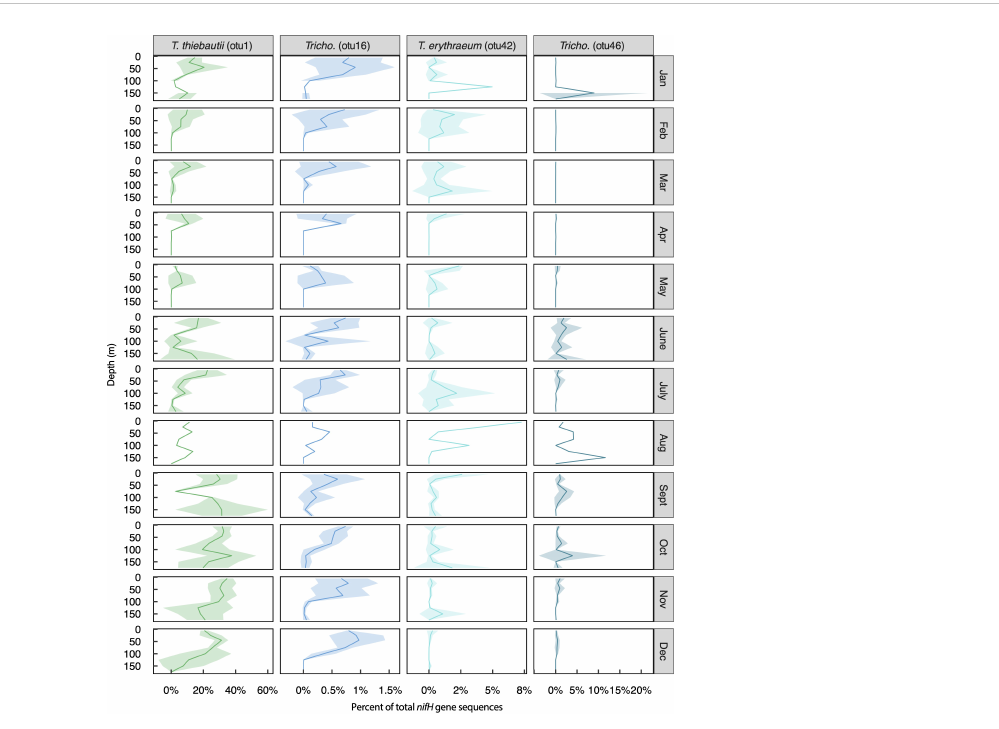
FIGURE 4 Relative abundances of the four most abundant Trichodesmium OTUs across months and depths. Solid lines represent mean values, shading represents +/- 1 standard deviation. Note that this timeseries includes only one observation during the month of